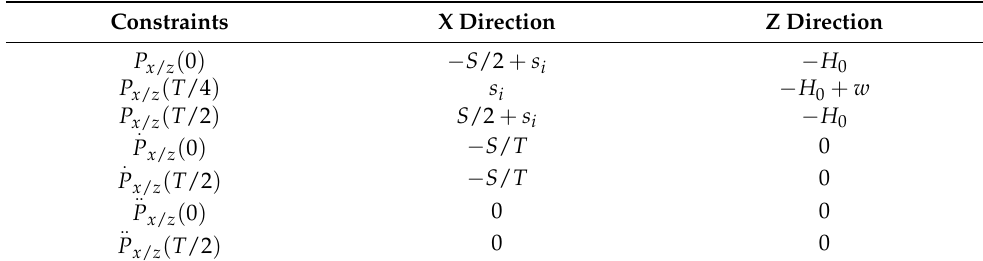
Table 5. System parameters in the simulation.